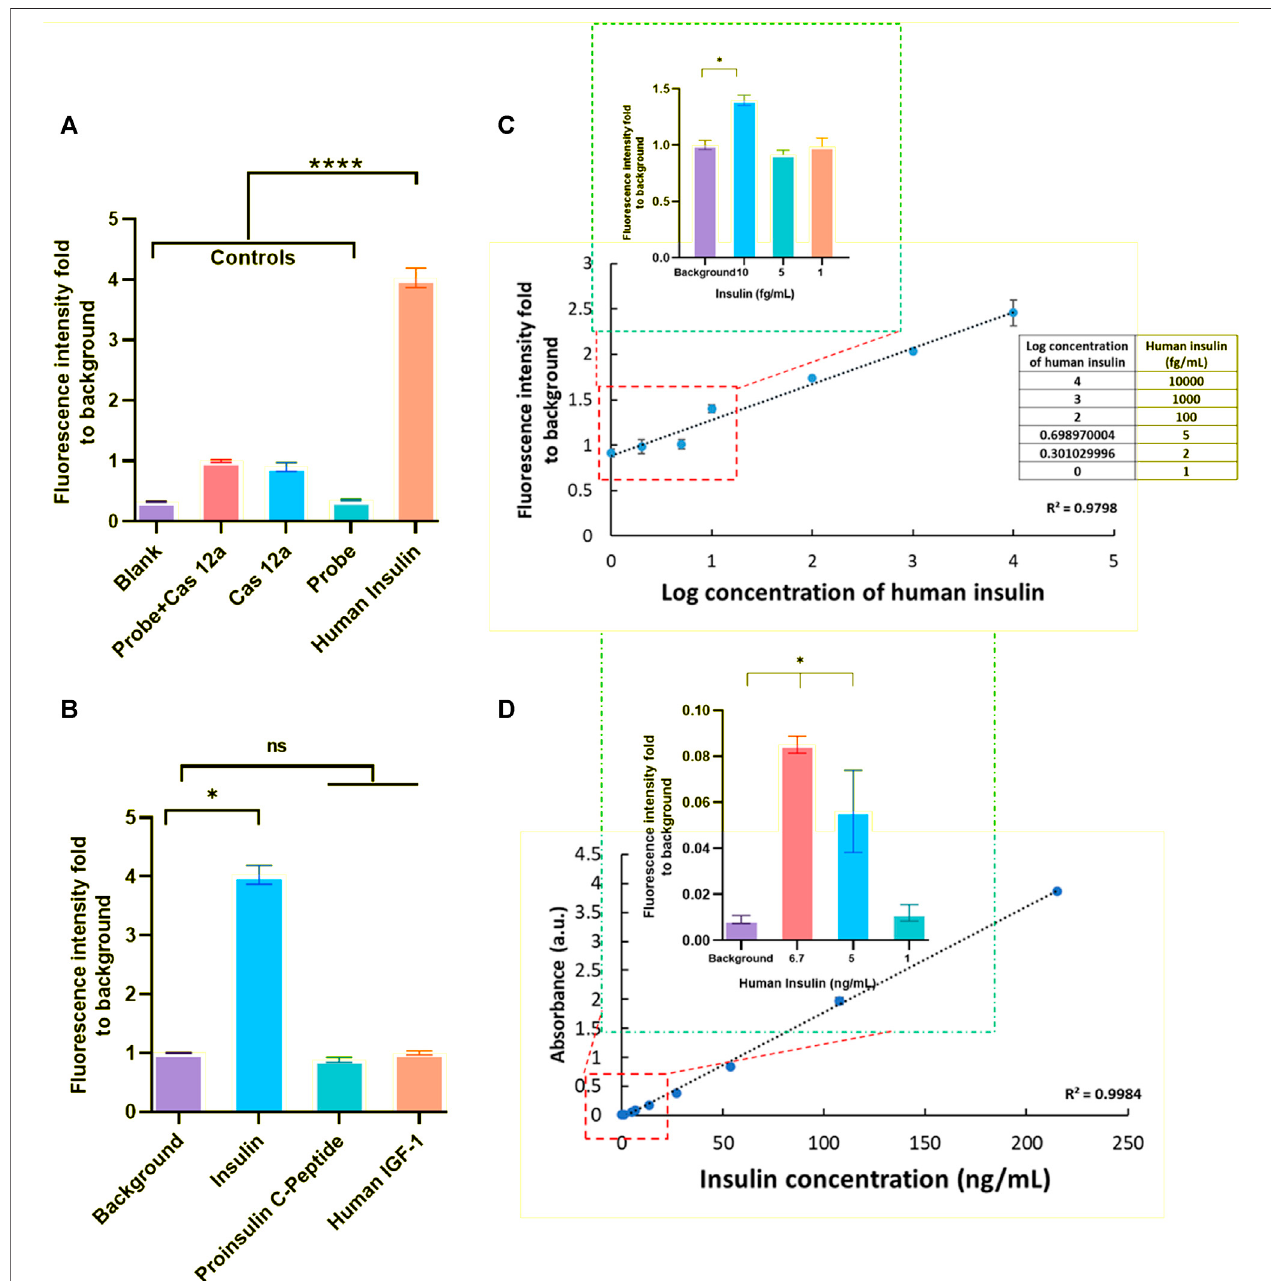
FIGURE 2 | Principle establishment of CANi. (A) Detection of human insulin (1 ng/ml) by CRISPR/Cas12a-assisted new immunoassay (CANi). Adding the probe and/or Cas12a reaction mix to the assay system was used as the control group for this assay. The triggering ssDNA 1 and guide RNA 1 and antibody pair #1 ( SupplementaryTablesS1,S3 )wereappliedinthisassay. (B) Speci fi citytestforhumaninsulin. (C) Calibrationcurveofhumaninsulin(rangingfrom1 ng/mlto1 fg/ml), andthelimitsofdetection(LOD)forhumaninsulinwas10 fg/ml. (D) Veri fi cationtestforhumaninsulinbyELISA.TheLODfordetectionofhumaninsulinwas5 pg/ml by ELISA. * indicated signi fi cant differences ( p < 0.05) and **** indicated signi fi cant differences ( p < 0.001) analyzed by two-way ANOVA.